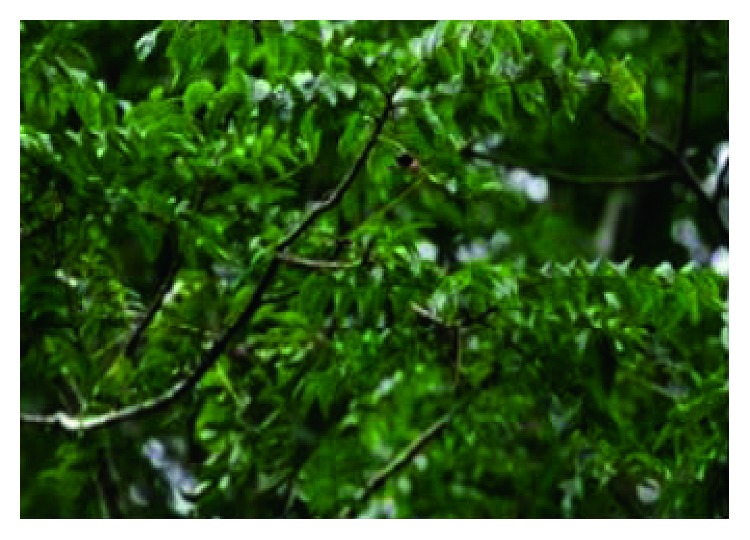

C. anisata (olmaa'ii) (Photo taken by Dandena Tamene on March, 2018).